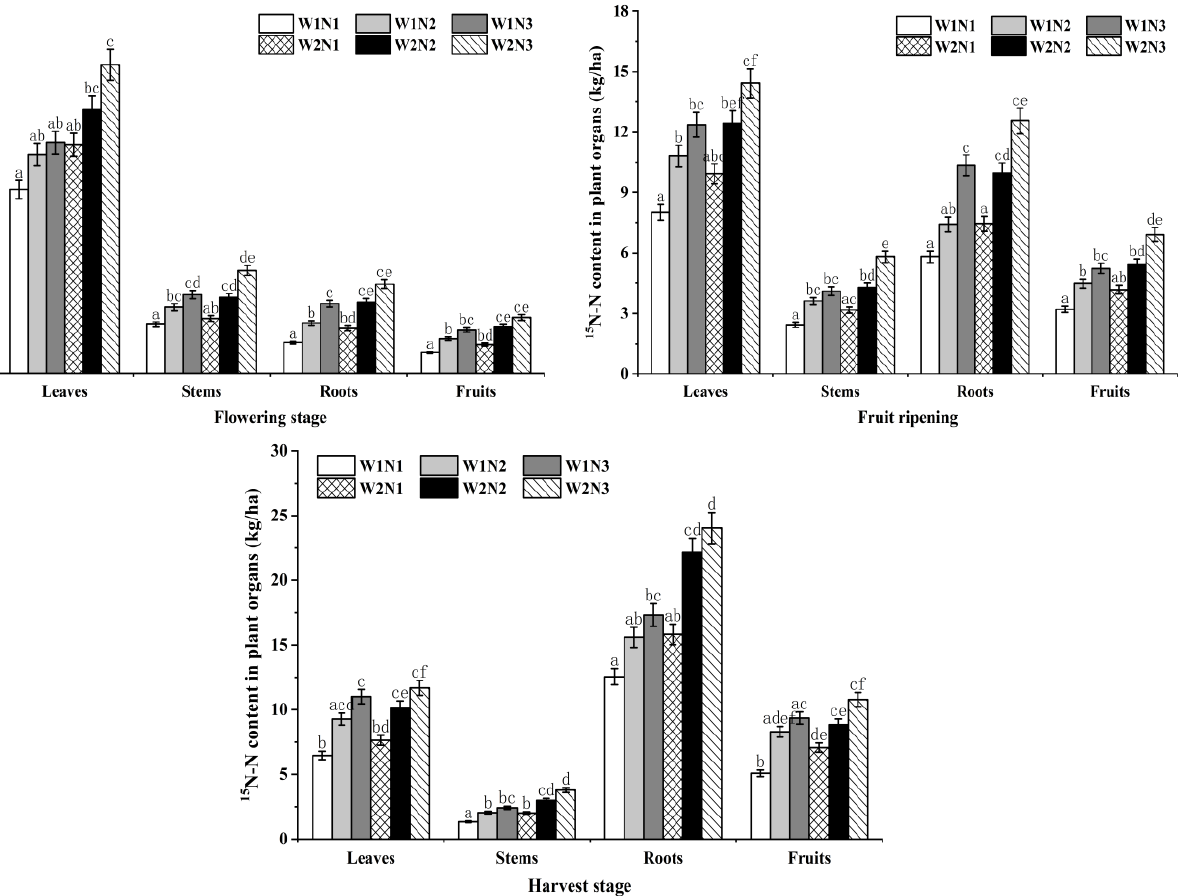
Figure 5. Distribution of 15 N-N in the different organs of vines at the flowering ( top left ), fruit ripening ( top right ), and harvesting stages ( bottom ). Note: different letters indicate significant differences between different treatments (at p < 0.05 (Tukey’s post hoc test).